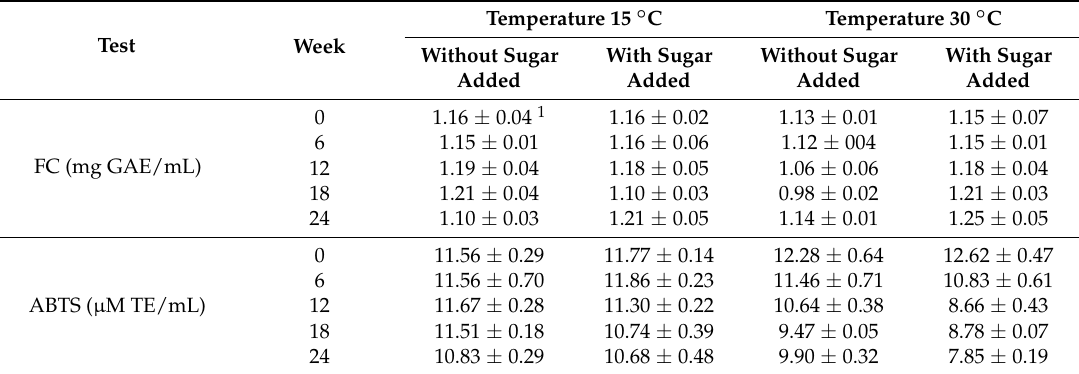
Table 7. Changes in substances reacting with Folin-Ciocalteu reagent (FC) content and antioxidant activity ABTS, of sour cherry liqueurs during 24 weeks storage in temperatures 15 ◦ C and 30 ◦